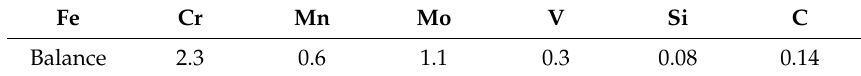
Table 3. Chemical composition in wt.% of the investigated 2.25Cr-1Mo-0.25V base metal steel plate.